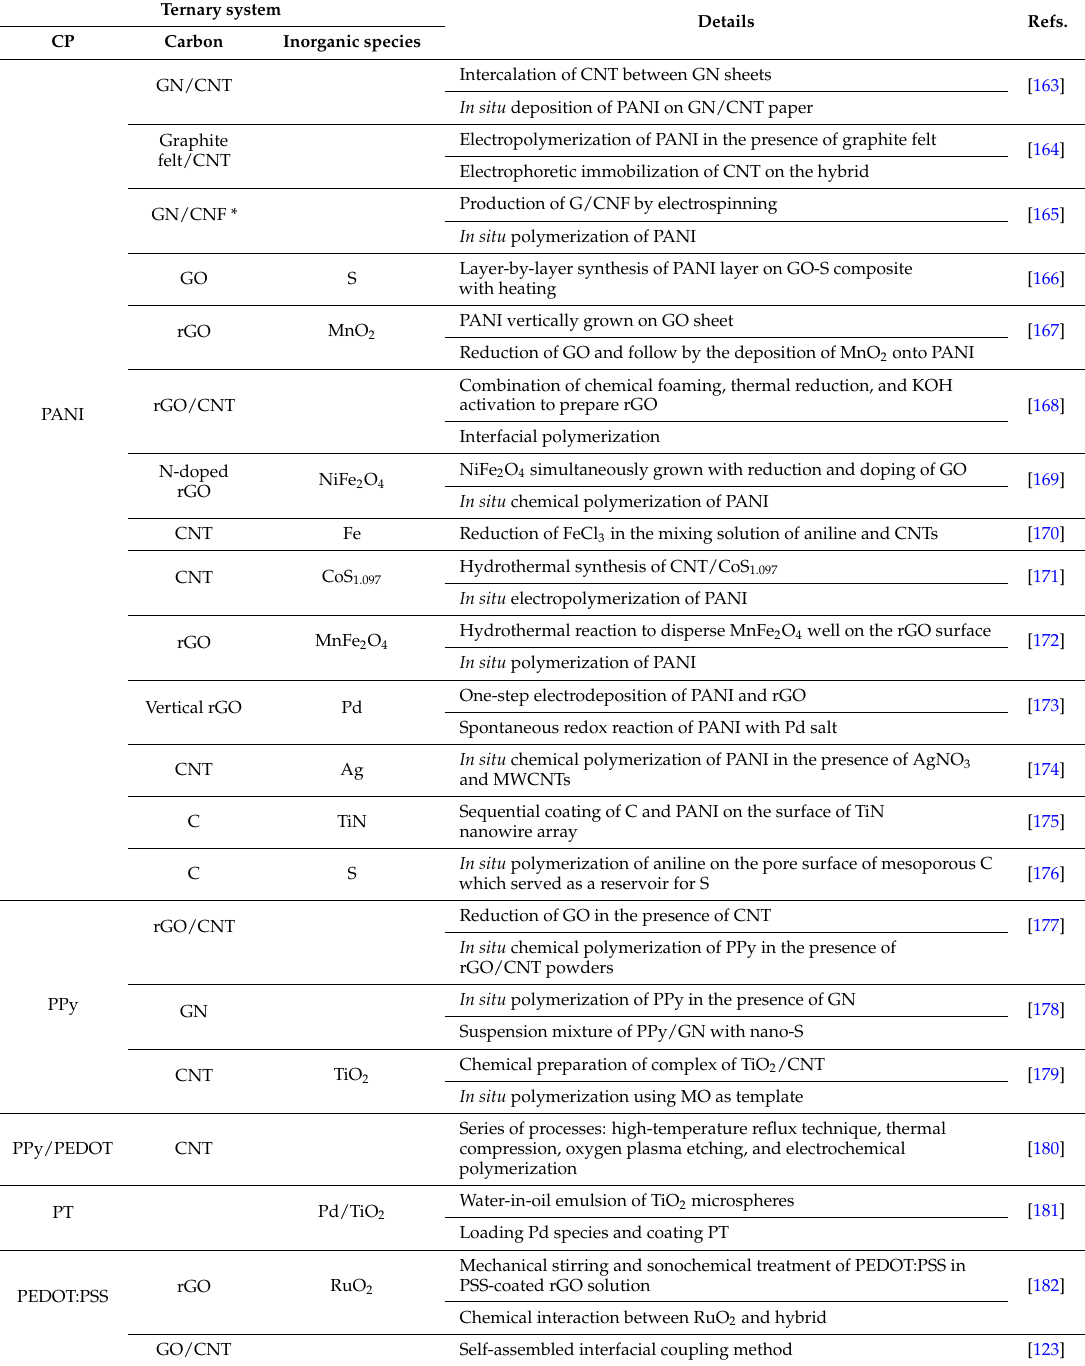
Table 9. Representative examples of ternary CP